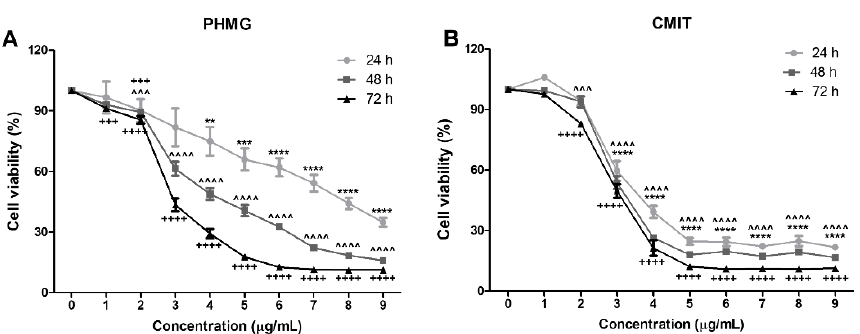
Figure 1. Evaluation of the cell viabilities of human pulmonary alveolar epithelial cells (HPAEpiCs) after exposure to polyhexamethylene guanidine (PHMG) and chloromethylisothiazolinone (CMIT). HPAEpiCs were incubated with various doses of ( A ) PHMG or ( B ) CMIT for 24, 48, and 72 h. Cell viability was measured in triplicate. Statistically significant differences were analyzed using one- way analysis of variance (ANOVA; ** p < 0.01, *** p < 0.001, **** p < 0.0001 versus 0 μg/mL 24 h; ^^^ p < 0.001, ^^^^ p < 0.0001 versus 0 μg/mL 48 h; +++ p < 0.001, ++++ p < 0.0001 versus 0 μg/mL 72 h).